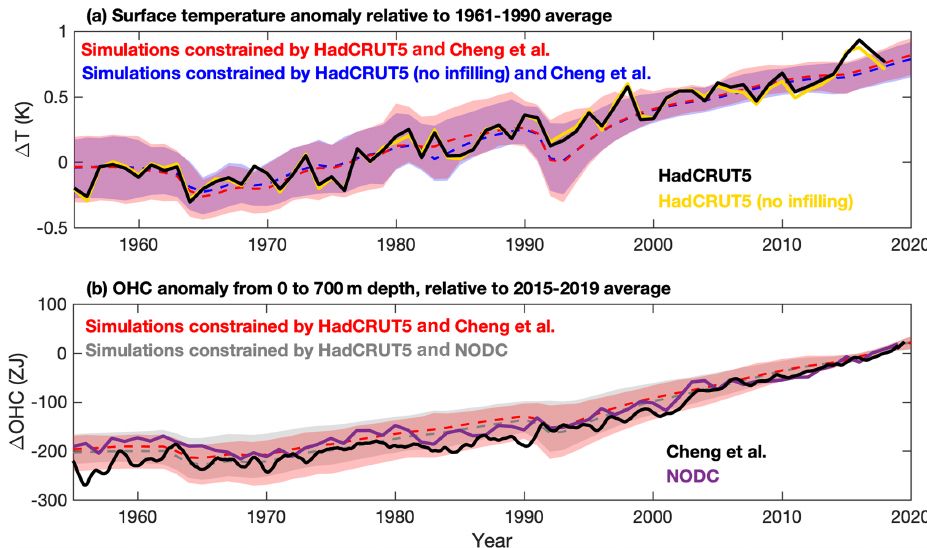
Figure 1. Surface temperature and ocean heat content anomalies from 1955 from datasets and dataset-constrained simulations. (a) Historic surface warming relative to the 1961–1990 average in the HadCRUT5 and HadCRUT5 (no infilling) surface temperature datasets (solid lines) and posterior ensemble simulations (dashed lines show ensemble medians, and shading shows 95% ensemble ranges) constrained by each temperature dataset, along with the Cheng et al. ocean heat content dataset. (b) Ocean heat content (OHC) anomaly in the upper 700m of the global ocean in the NODC and Cheng et al. datasets (solid lines) and posterior ensemble simulations (dashed lines show ensemble medians, and shading shows 95% ensemble ranges) constrained by each OHC dataset along with the HadCRUT5 temperature